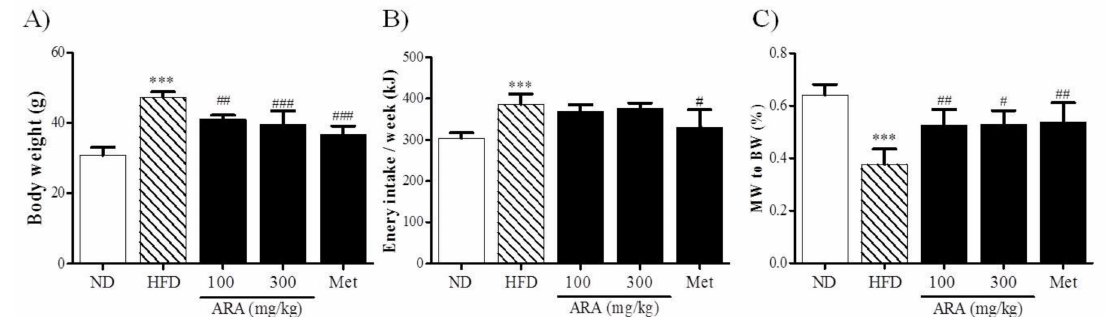
Figure 1. Effects of ARA on body weight. ( A ) body weight; ( B ) energy intake; ( C ) gastrocnemius muscle to body weight ratios. Results are presented as means ± standard errors of the mean (SEM) ( n = 5). *** p < 0.001 versus normal chow fed controls (the ND group); ### p < 0.001, ## p < 0.01, # p < 0.05 versus the high fat diet fed mice (the HFD group). ARA, Atractylodis Rhizoma Alba; ND, normal diet; HFD, high fat diet; BW, body weight; MW, muscle